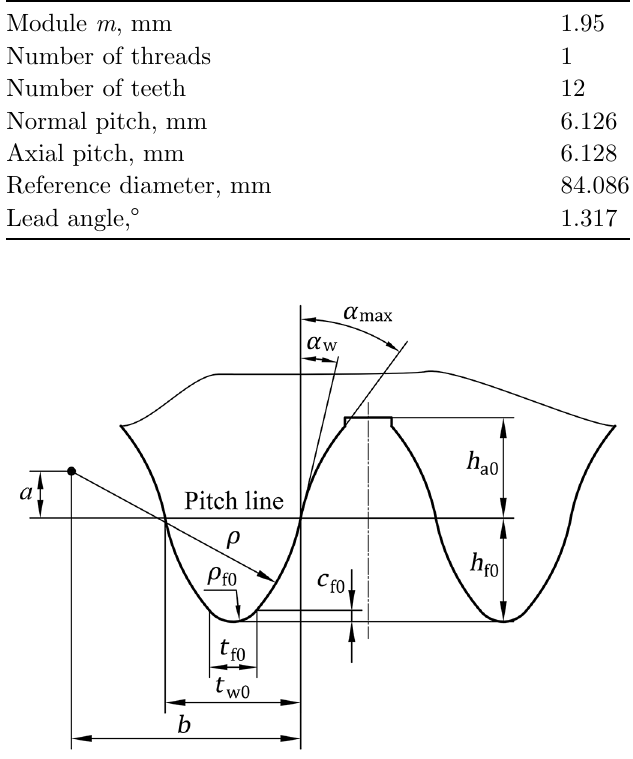
Fig. 5. Hob cutter tooth pro fi